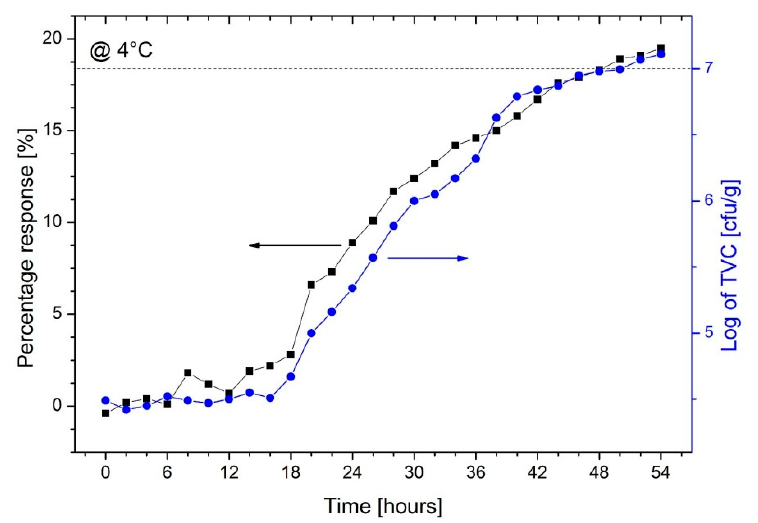
Figure 9. Sensor response (black squares, left scale) and bacterial population (blue circles, right scale) in fresh mackerel fish over a period of 40 h at 4 °C.